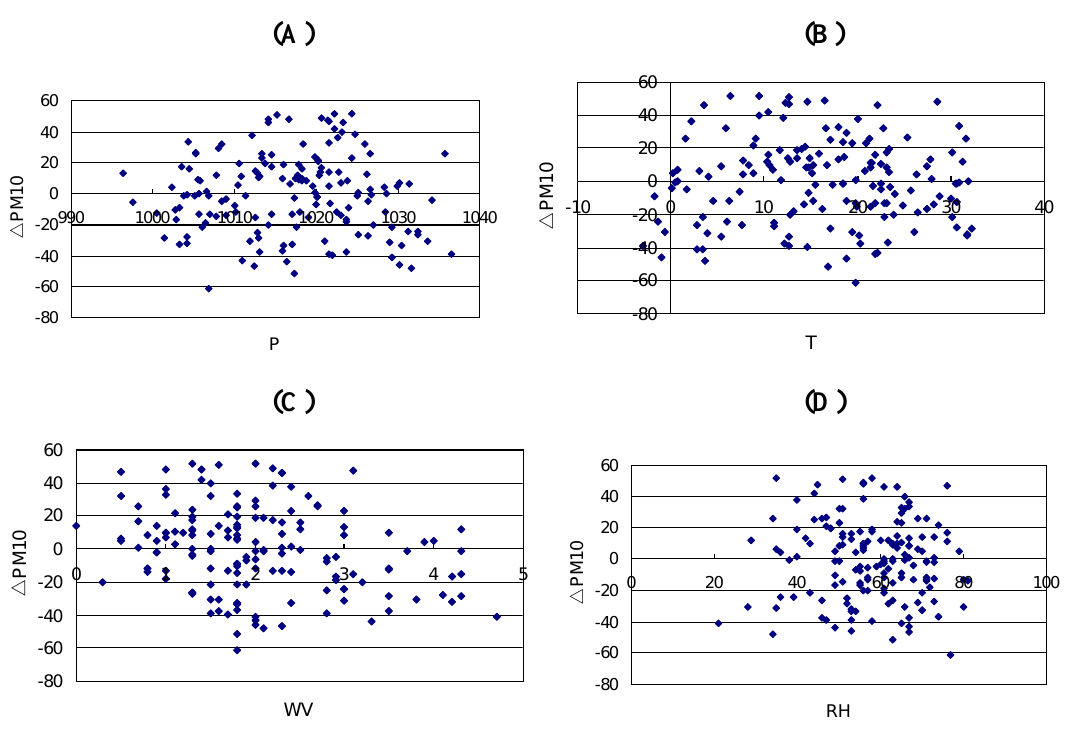
estimates predicted from AOT versus 10